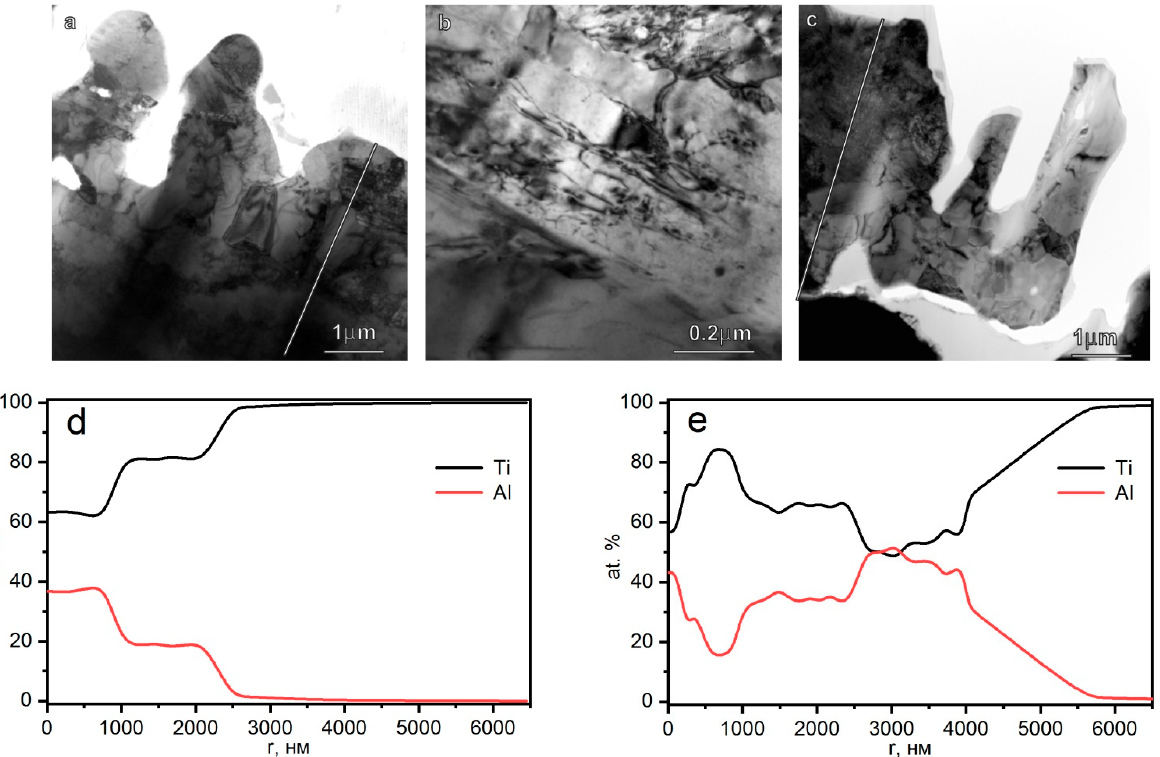
Figure 2. Cross-sections of the TEM images of the copper alloy treated with titanium ions: ( a , b ) 6 min; ( c ) 12 min. Depth distribution of the elements: for copper treated with titanium ions over 6 min ( d ) and over 12 min ( e ).